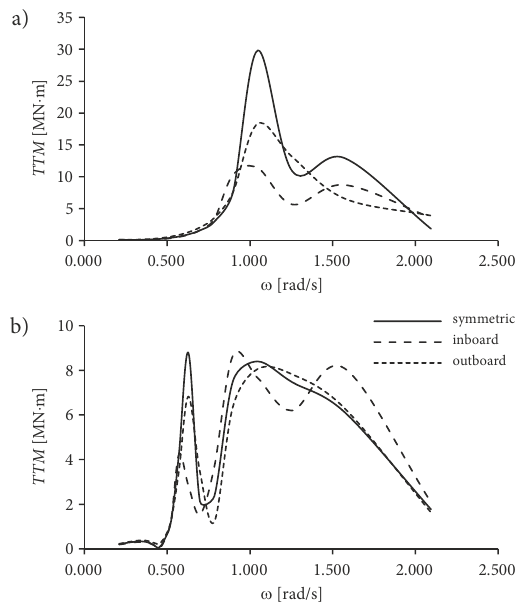
Figure 14. RAOs of transverse torsion moments TTM in: a – beam seas; b – bow quartering seas